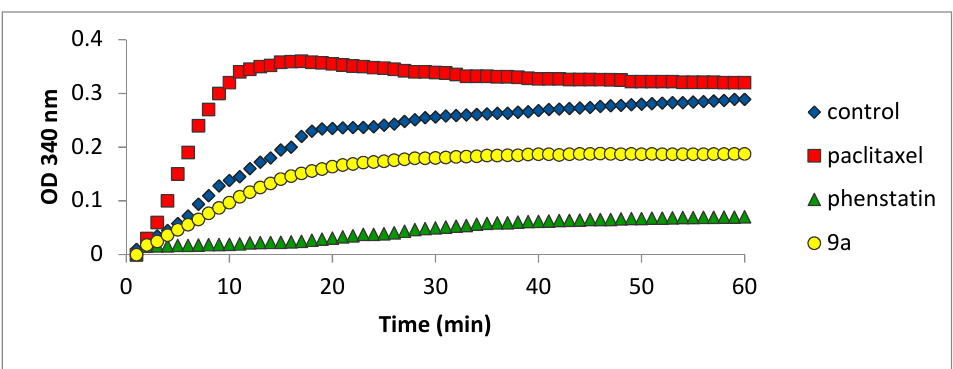
compound 9a on tubulin polymerization (Figure 2). Paclitaxel (as tubulin stabiliser) and phenstatin (as tubulin polymerisation inhibitor) were used as positive controls.